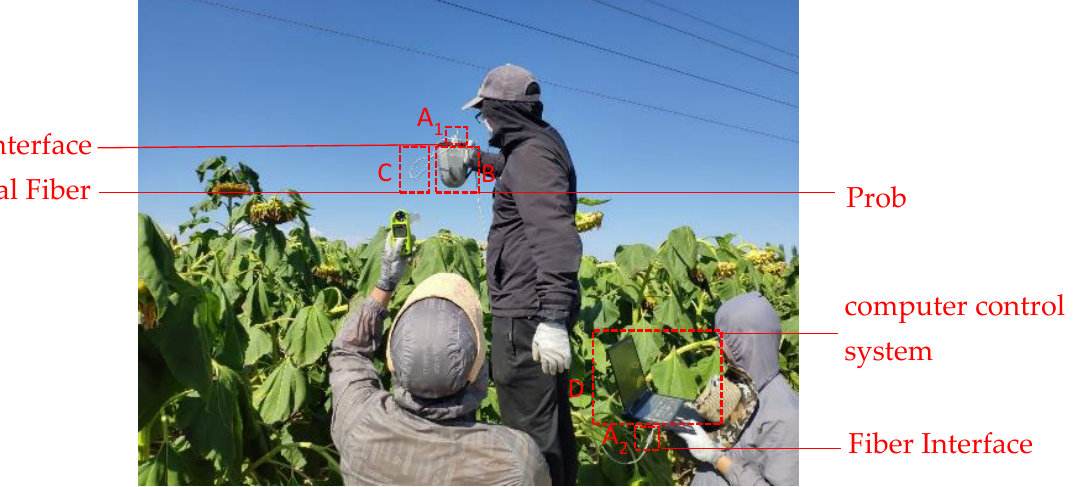
Figure 4. Schematic diagram of spectral curve collection work.